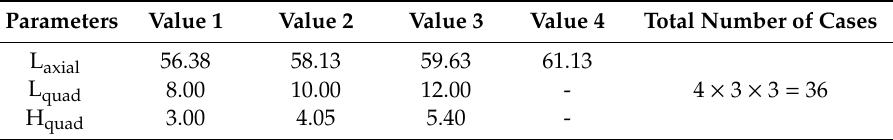
Table 3. Geometric parameters for novel designs (units: mm).